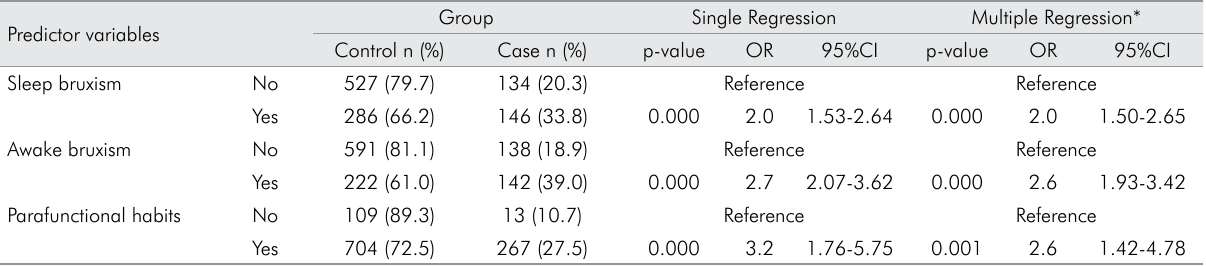
Table 2. Single and multiple logistic regression models for prediction of painful TMD for each predictor variable. All predictor variables are presented as absolute number (n) and percentages (%) stratified by the presence of painful TMD.